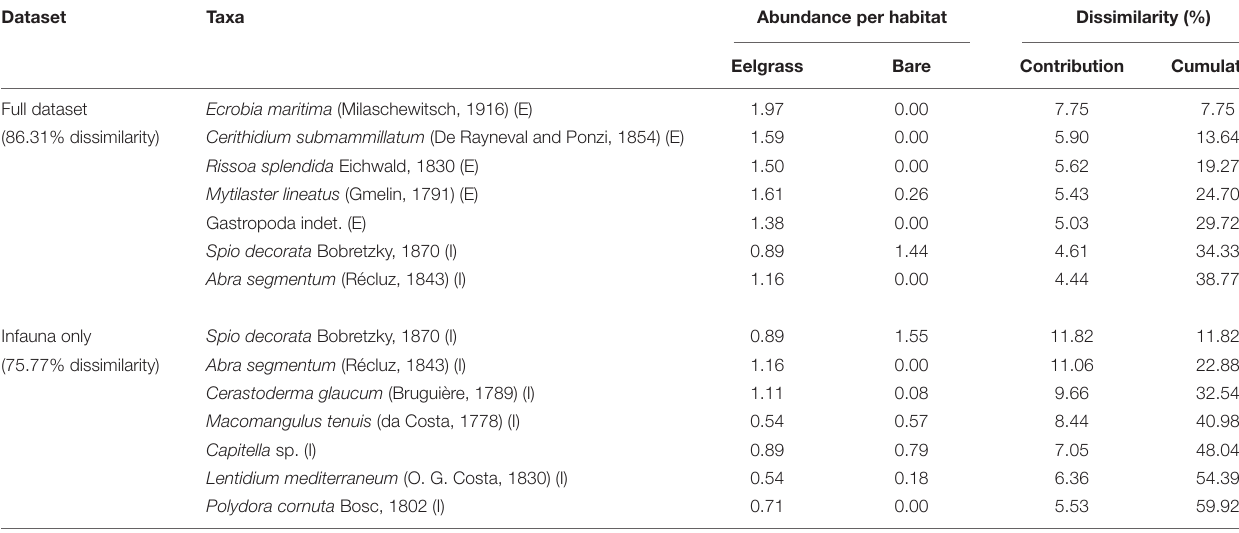
TABLE 1 | Summary of SIMPER analyses identifying the (seven) main taxa contributing to the dissimilarity between communities associated with eelgrass and bare sediment habitats for summer and fall surveys combined. Dataset Taxa Abundance per habitat Dissimilarity (%) Eelgrass Bare Contribution